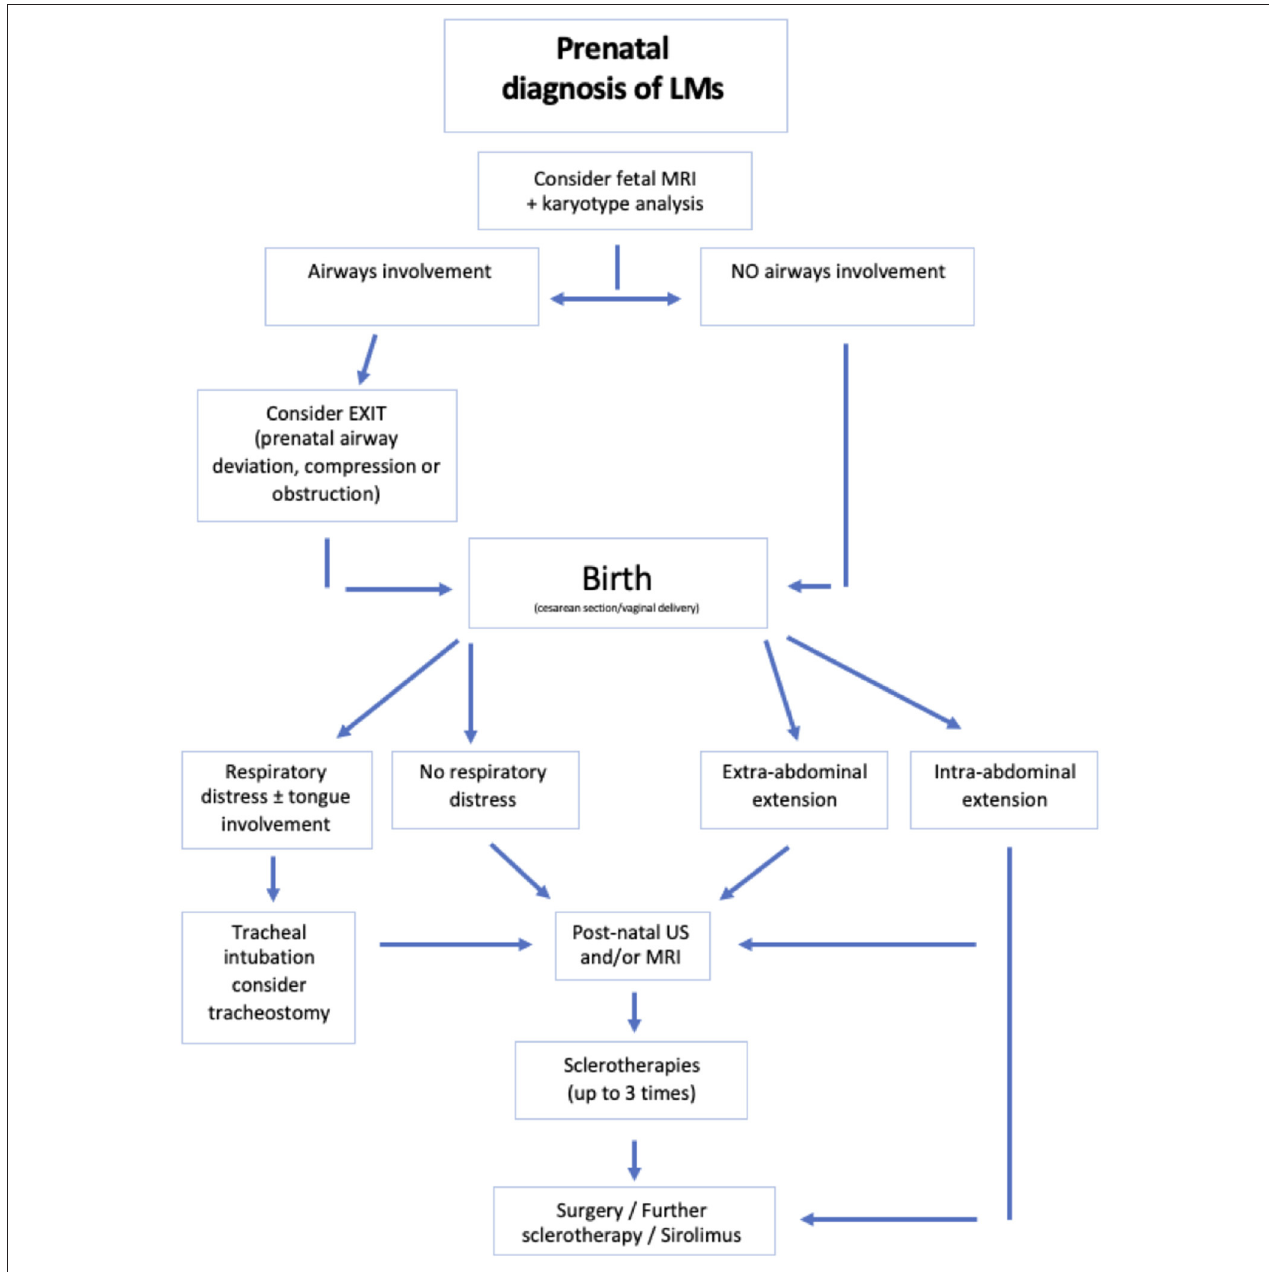
FIGURE 6 | Proposed treatment